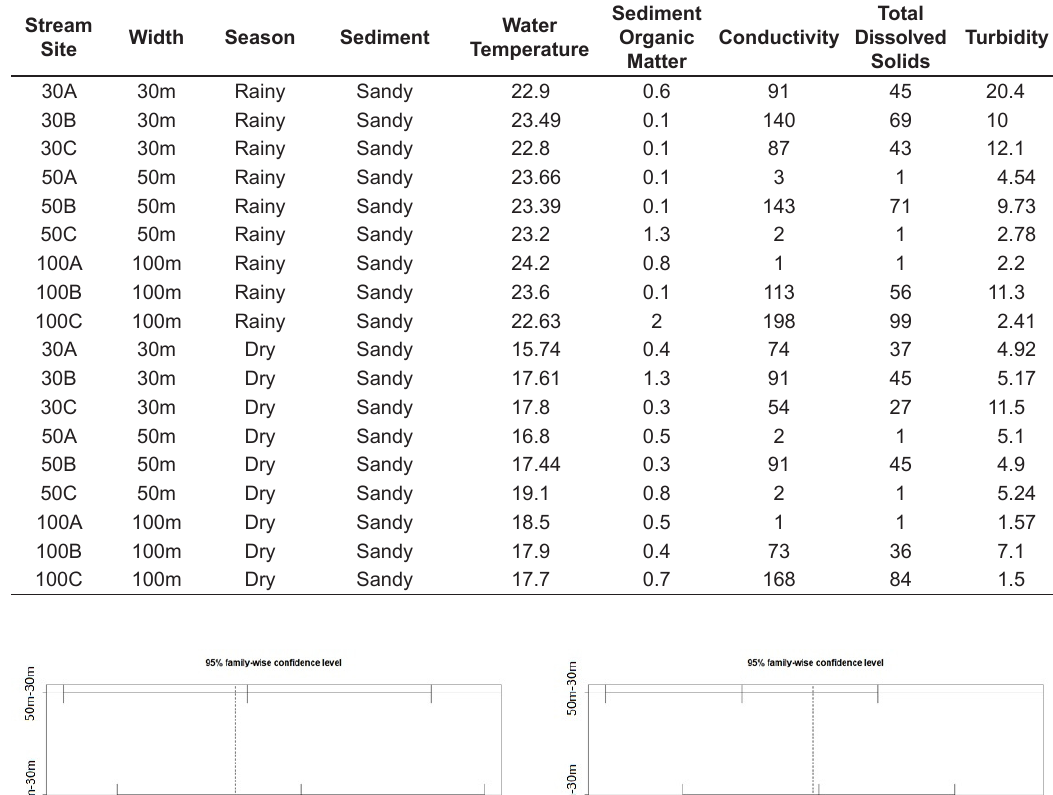
Table 1. Measured physical habitat and water quality metrics.